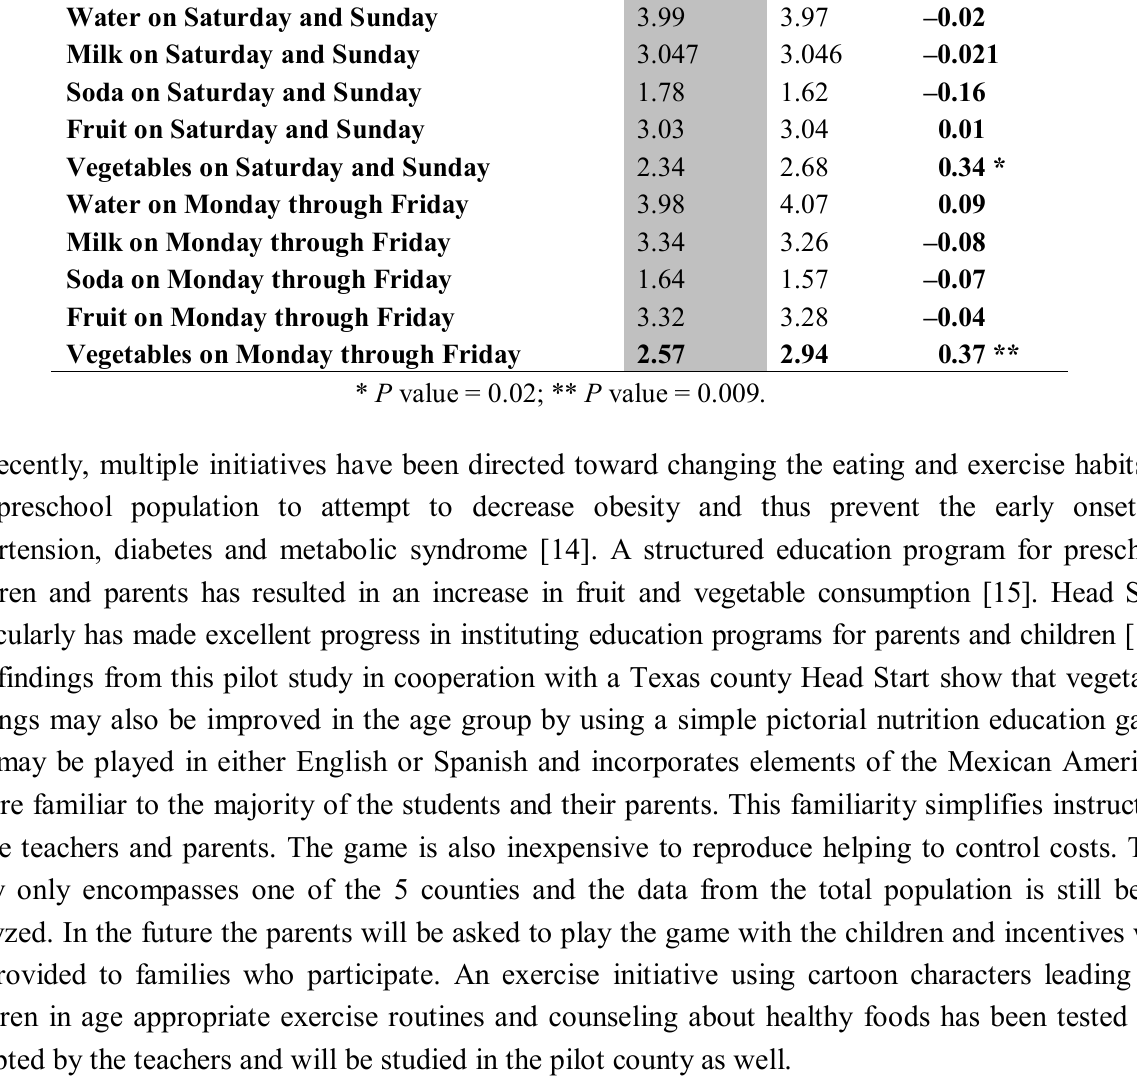
Table 1. Mean Values for Daily Servings of Foods and Water by the Study Population Before and after the Intervention. Servings per day(Mean for the population) Before After Difference Water on Saturday and